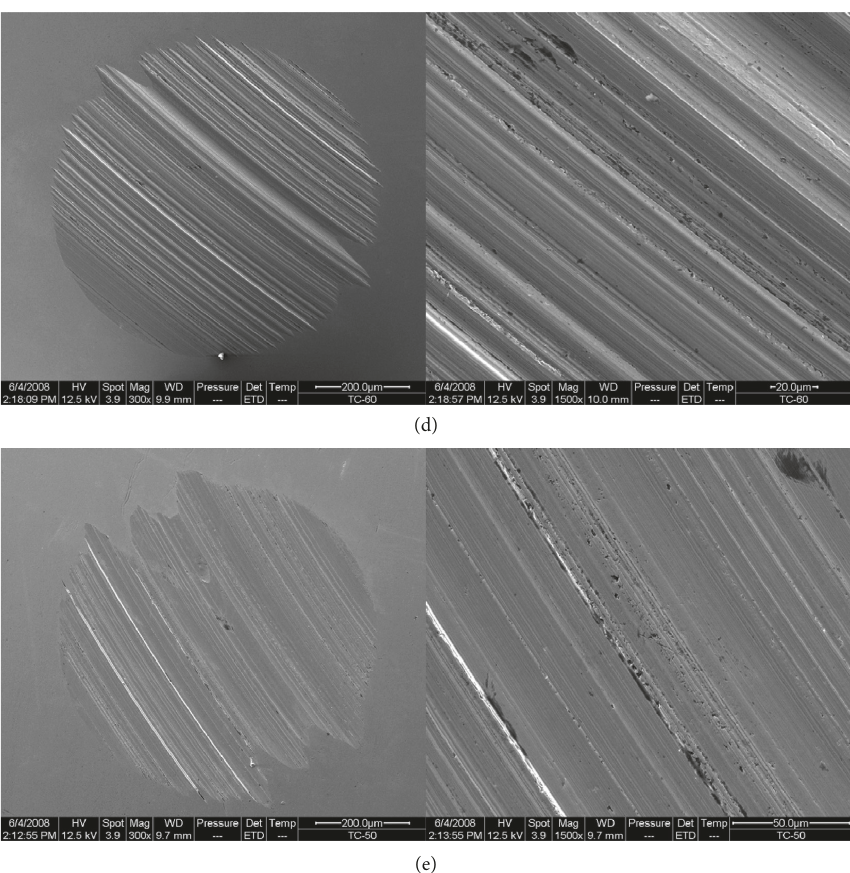
Figure 1: SEM photographs of worn scar lubricated by different oils under different loads: (a) oil containing TiDDC and BNO at 392N; (b) oil containing TiDDC and BNO at 490N; (c) oil containing TiDDC and BNO at 588N; (d) oil containing TiDDC at 588N; (e) oil containing BNO at